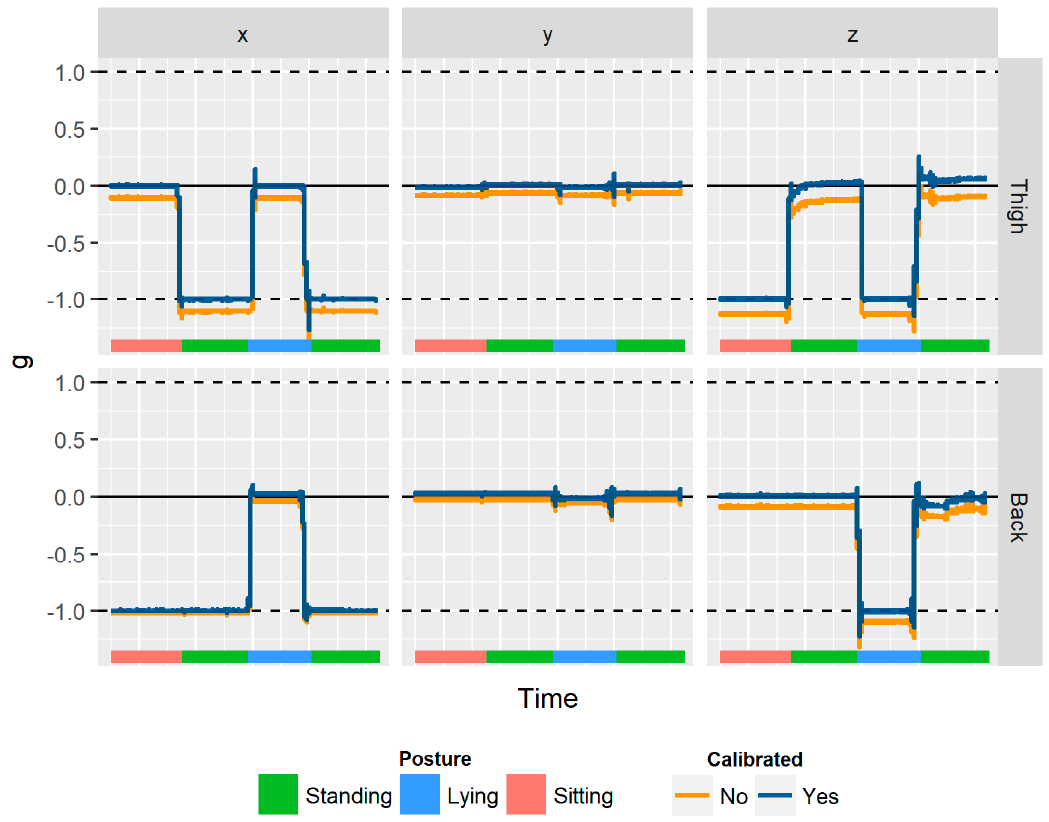
Figure 2. Example of pre- and post-calibration motion sensor outputs for paired Axivity AX3 accelerometers at three different postural states (standing, lying, sitting).